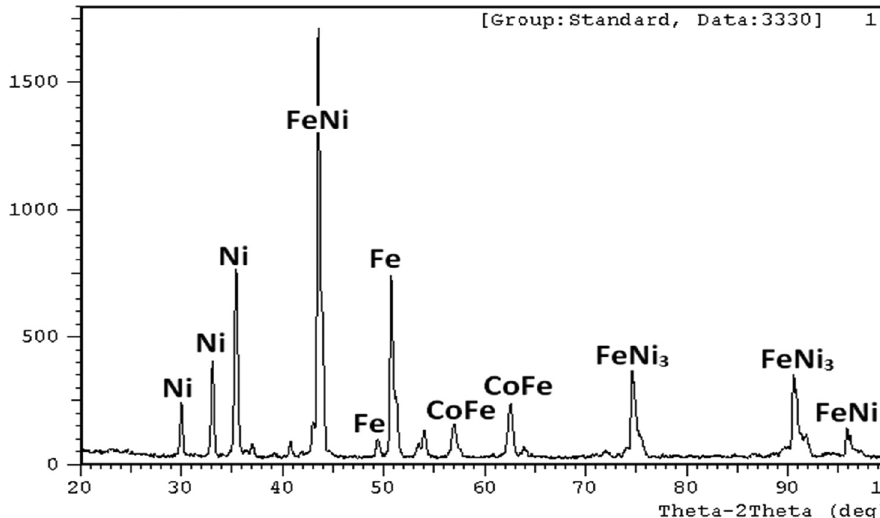
Figure 13: X - ray di ff raction of the ( Fe – 20% Co ) 60% Ni specimen at